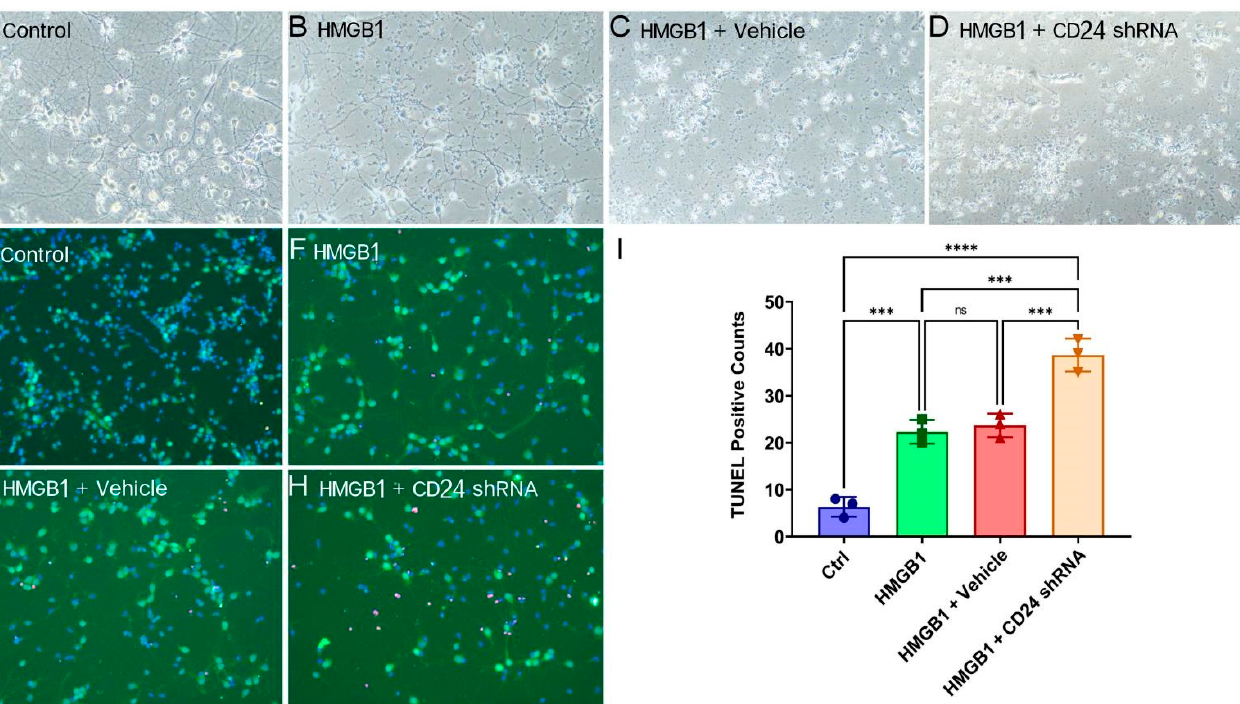
Figure 4. Representative photomicrographs of cocultured neurons under light microscopy ( A – D ). Representative photomicrographs ( E – H ) and quantification ( I ) of TUNEL immunofluorescence staining. Green stains for NeuN, red stains for TUNEL, and DAPI stains for nucleus. Scale bar: 20 μ m. Ns = not significant, ** p < 0.01, *** p < 0.001, **** p < 0.0001 vs. control or indicated groups. Statistical comparison was conducted using one-way ANOVA; p < 0.05 was considered statistically significant.